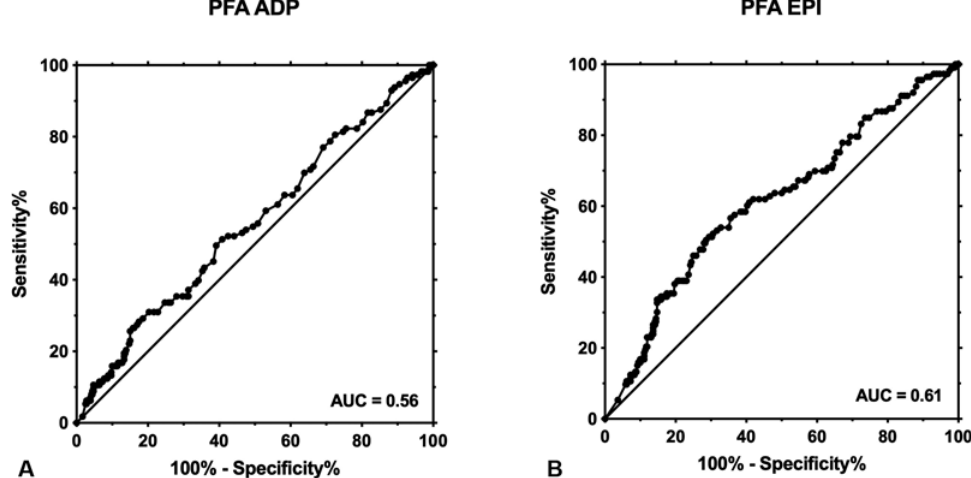
Fig. 3 The receiver operating characteristics (ROC) curve of PFA closure times for the presence of a platelet function disorder. ( A ) PFA ADP: area under the ROC curve (AUC): 0.56 (95% CI 0.50, 0.62). At a threshold of 130 seconds, sensitivity was 19.5% (95% CI 12.6, 30.0) and speci fi city 86.4% (95% CI 82.4, 89.8). ( B ) PFA EPI: AUC 0.61 (0.55, 0.67). At a threshold of 170 seconds, sensitivity was 44.3% (34.9, 53.9) and speci fi city was 75.6% (70.8, 79.9). EPI, epinephrine; ADP, adenosine diphosphate; PFD, platelet function